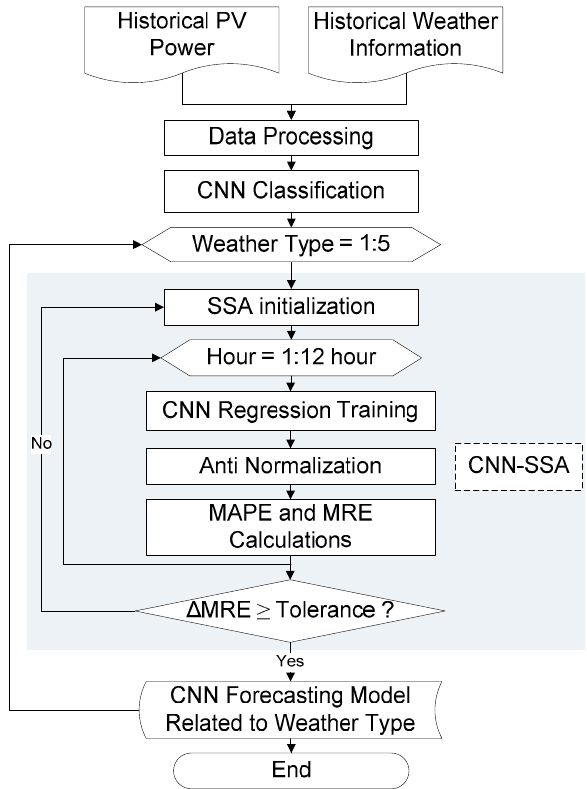
Figure 3. Training stage. MAPE : Mean absolute percentage error, MRE : Mean relative error, SSA: Salp swarm algorithm.